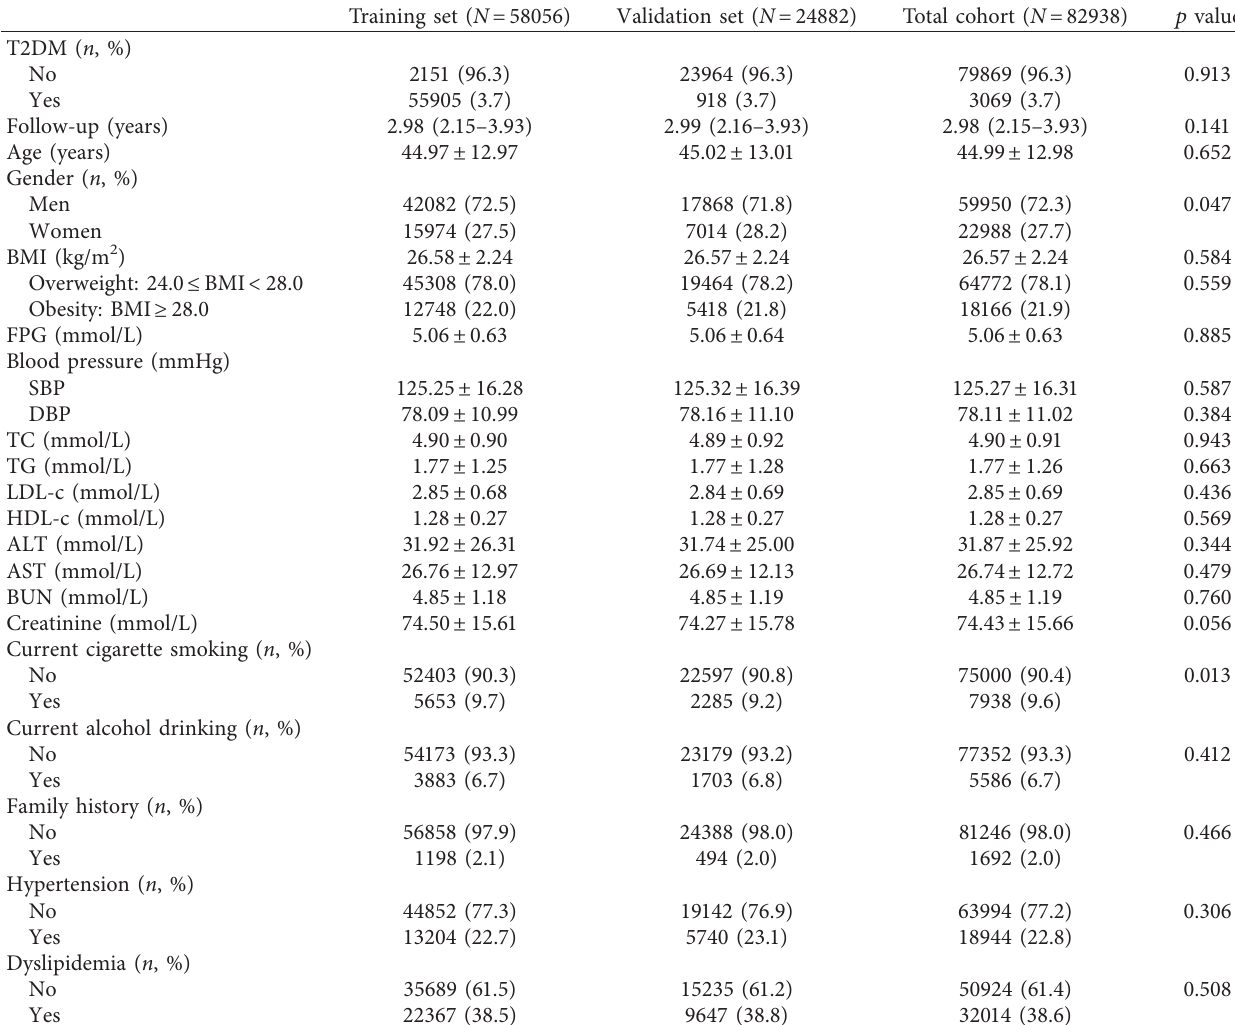
Table 1: Characteristics of the subjects in the primary and validation